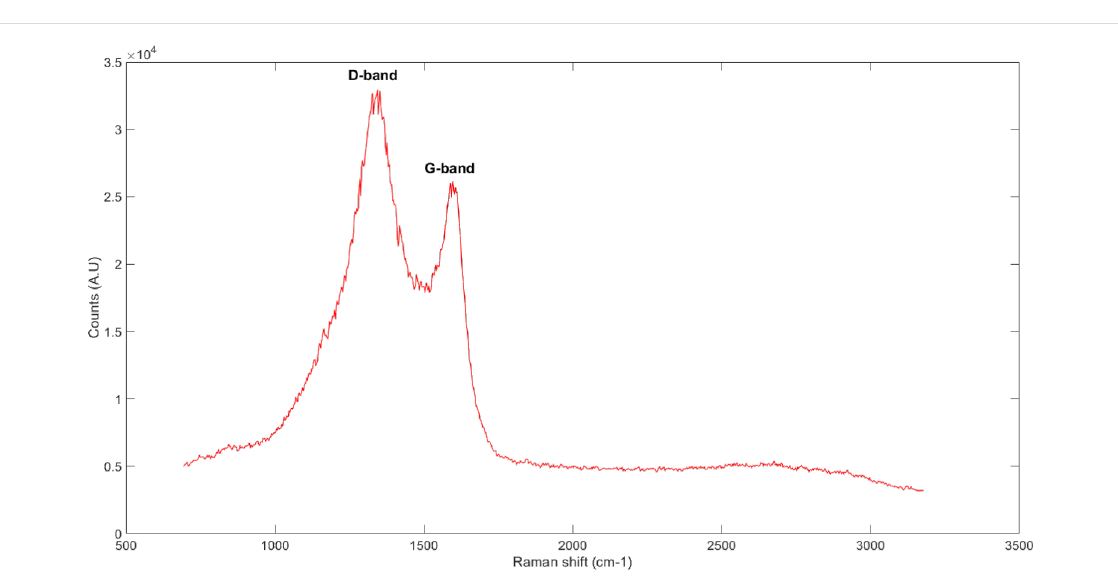
Figure 4: Raman spectrum of glassy carbon tubules. Both D-band and G-band are sharp and well defined, which indicates graphitic rather than amor- phous carbon [19].